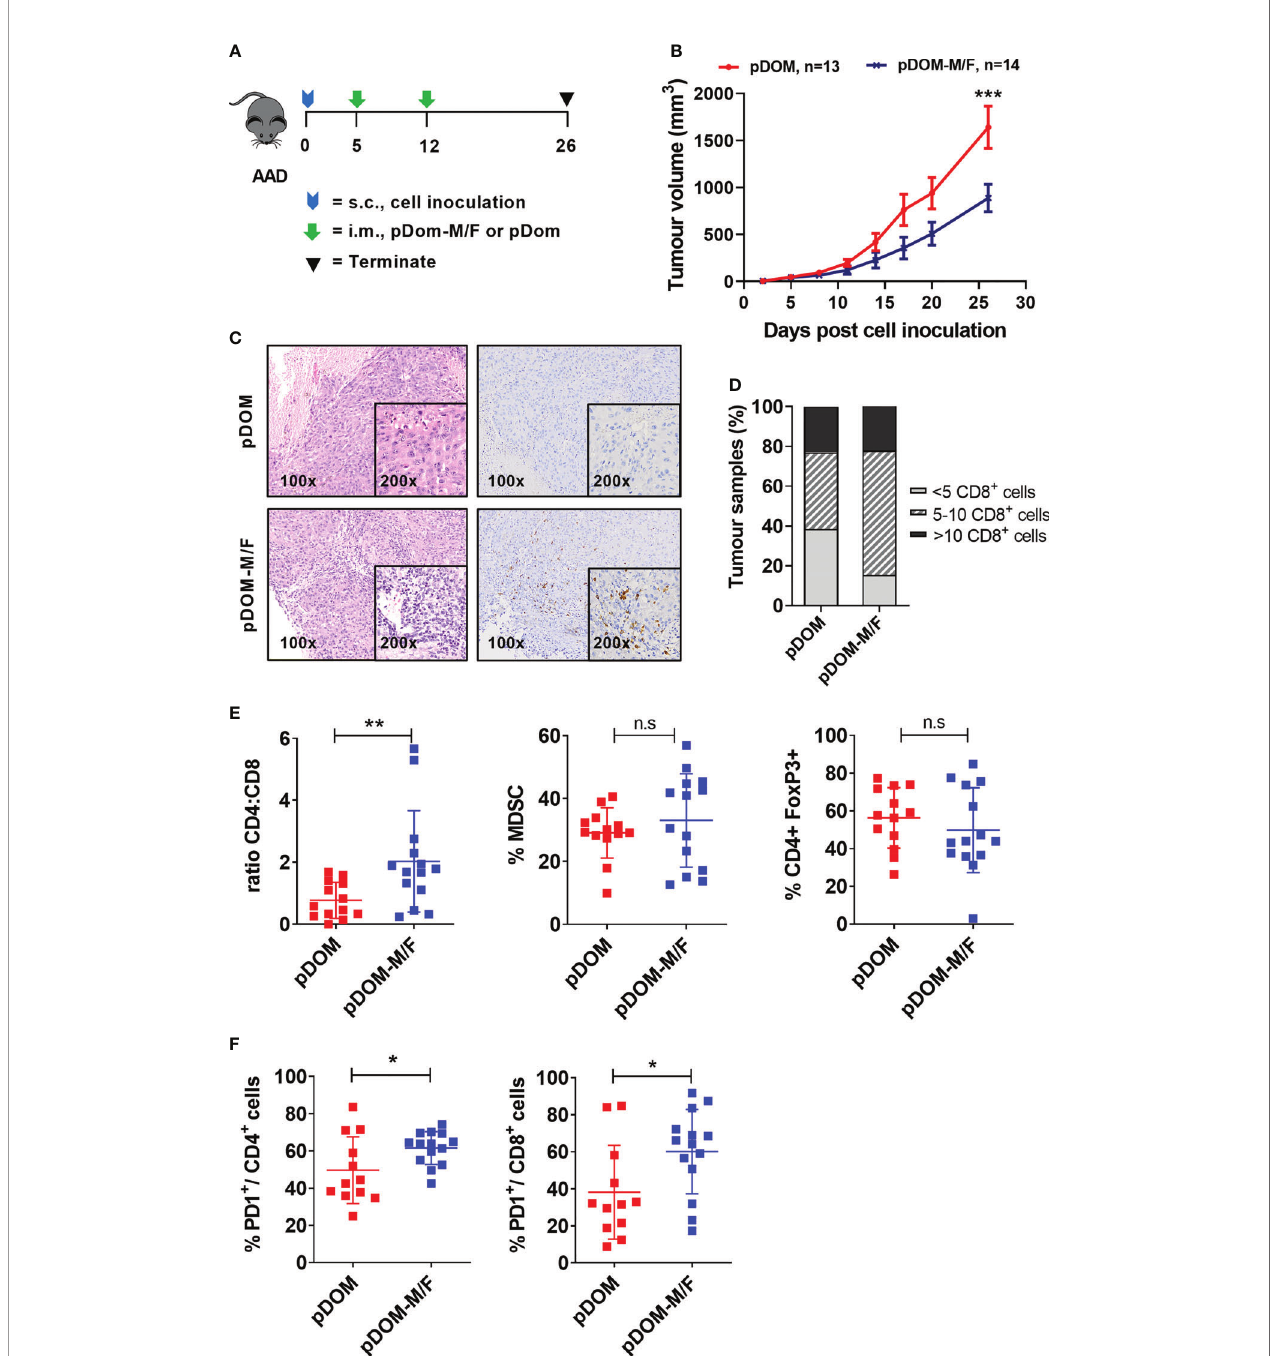
FIGURE 3 | pDom-M/F vaccines enhance anti-tumour immunity by increasing in fi ltration of immune cells into the tumour. (A) Schematic of vaccination schedule, mice were inoculated with the BAM cell line and randomized to either received vaccination of pDom-M/F (pDom-M and pDom-F; 50 m g each vaccine per mouse) or pDom (50 m g per mouse) as vector control. Upon termination at endpoint, tumours from vaccinated animals were harvested for analysis of TILs. (B) Tumour growth inhibition was signi fi cant in mice that received pDom-M/F in comparison to mice which received pDom. Data is expressed as mean ± SEM. (C) Increased immune cells in fi ltration was observed in pDom-M/F group as opposed to pDom (left). IHC staining demonstrated CD8+ T cells were induced by pDom-M/F vaccination (right). Images shown were at 100X and 200X magni fi cations. (D) Analysis of IHC data demonstrated higher proportion of tumour from pDom-M/F group harbouring CD8+ T cells as compared to pDom vector control group. (E) pDom-M/F group signi fi cantly induced more CD4+ T cells. (F) Both PD1+CD4+ and PD1+CD8+ T cells were signi fi cantly upregulated in pDom-M/F vaccinated animals when compared to pDom group. Unless otherwise stated, all data are expressed as mean ± SD and pooled data from 2 independent experiments are shown for (B – F) . Symbols *, **, ***, ns denote p < 0.05, p < 0.01, p < 0.001 and not signi fi cant